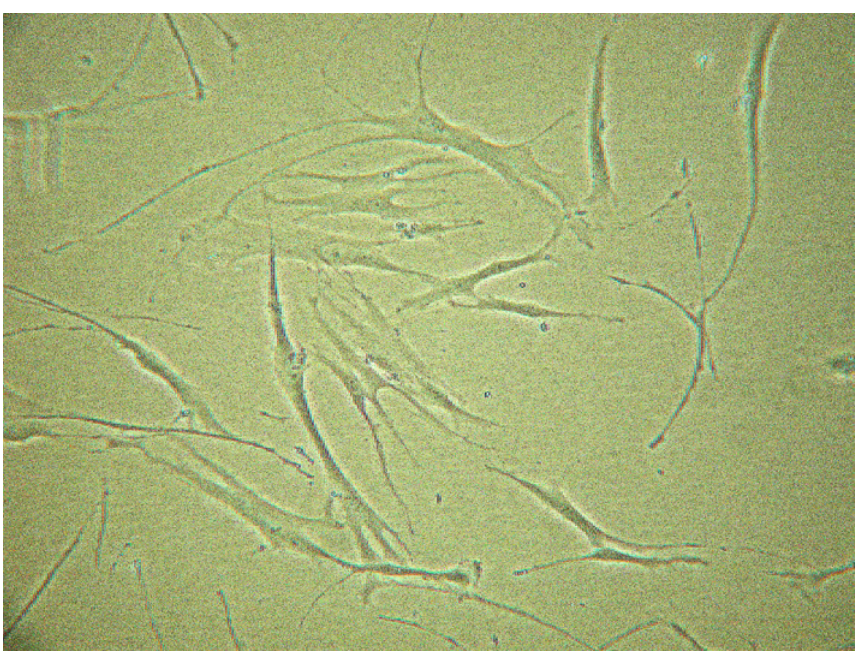
FIGURE 4 - Human fibroblasts in Petri dish with citoplasmatic prolongations (100x